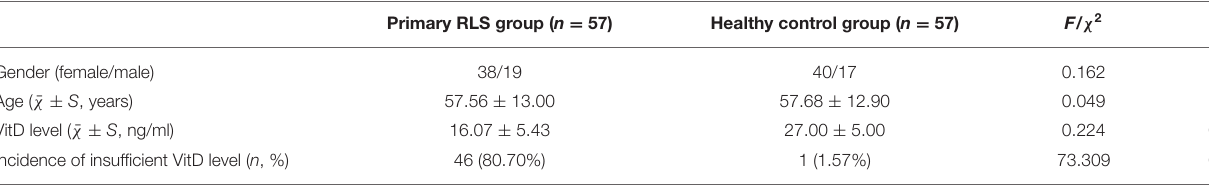
TABLE 1 | Comparison of gender, age, and VitD level between RLS group and healthy control group.